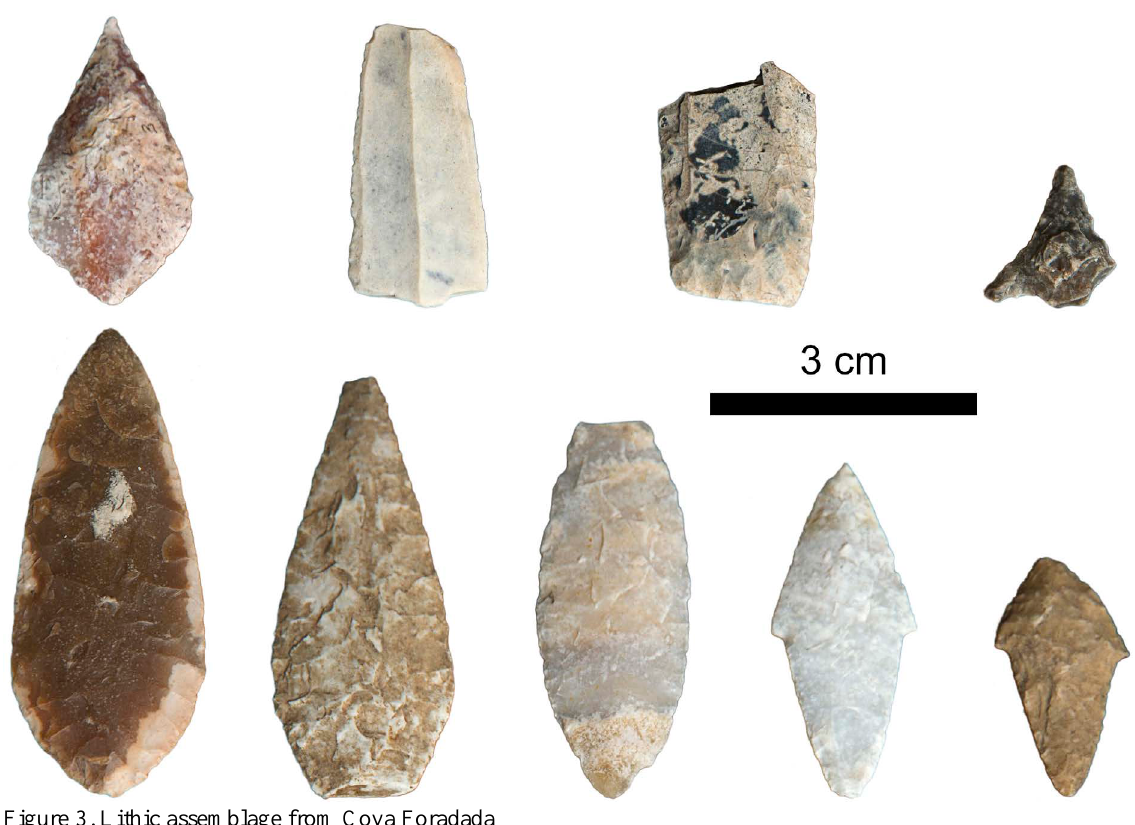
Figure 3. Lithic assemblage from Cova Foradada